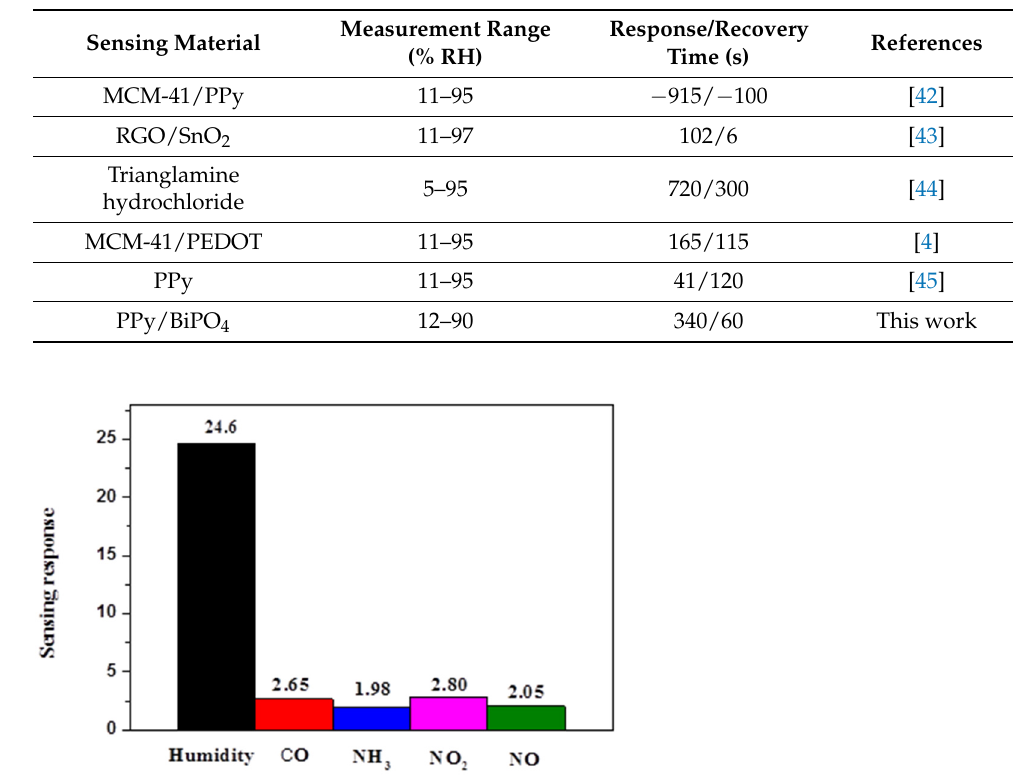
Figure 7. Response and recovery characteristics of 5 wt.% PPy/BiPO 4 composites. Table 1. Comparative humidity-sensing performance of modified conductive polymer-based sensors with previously published reports.